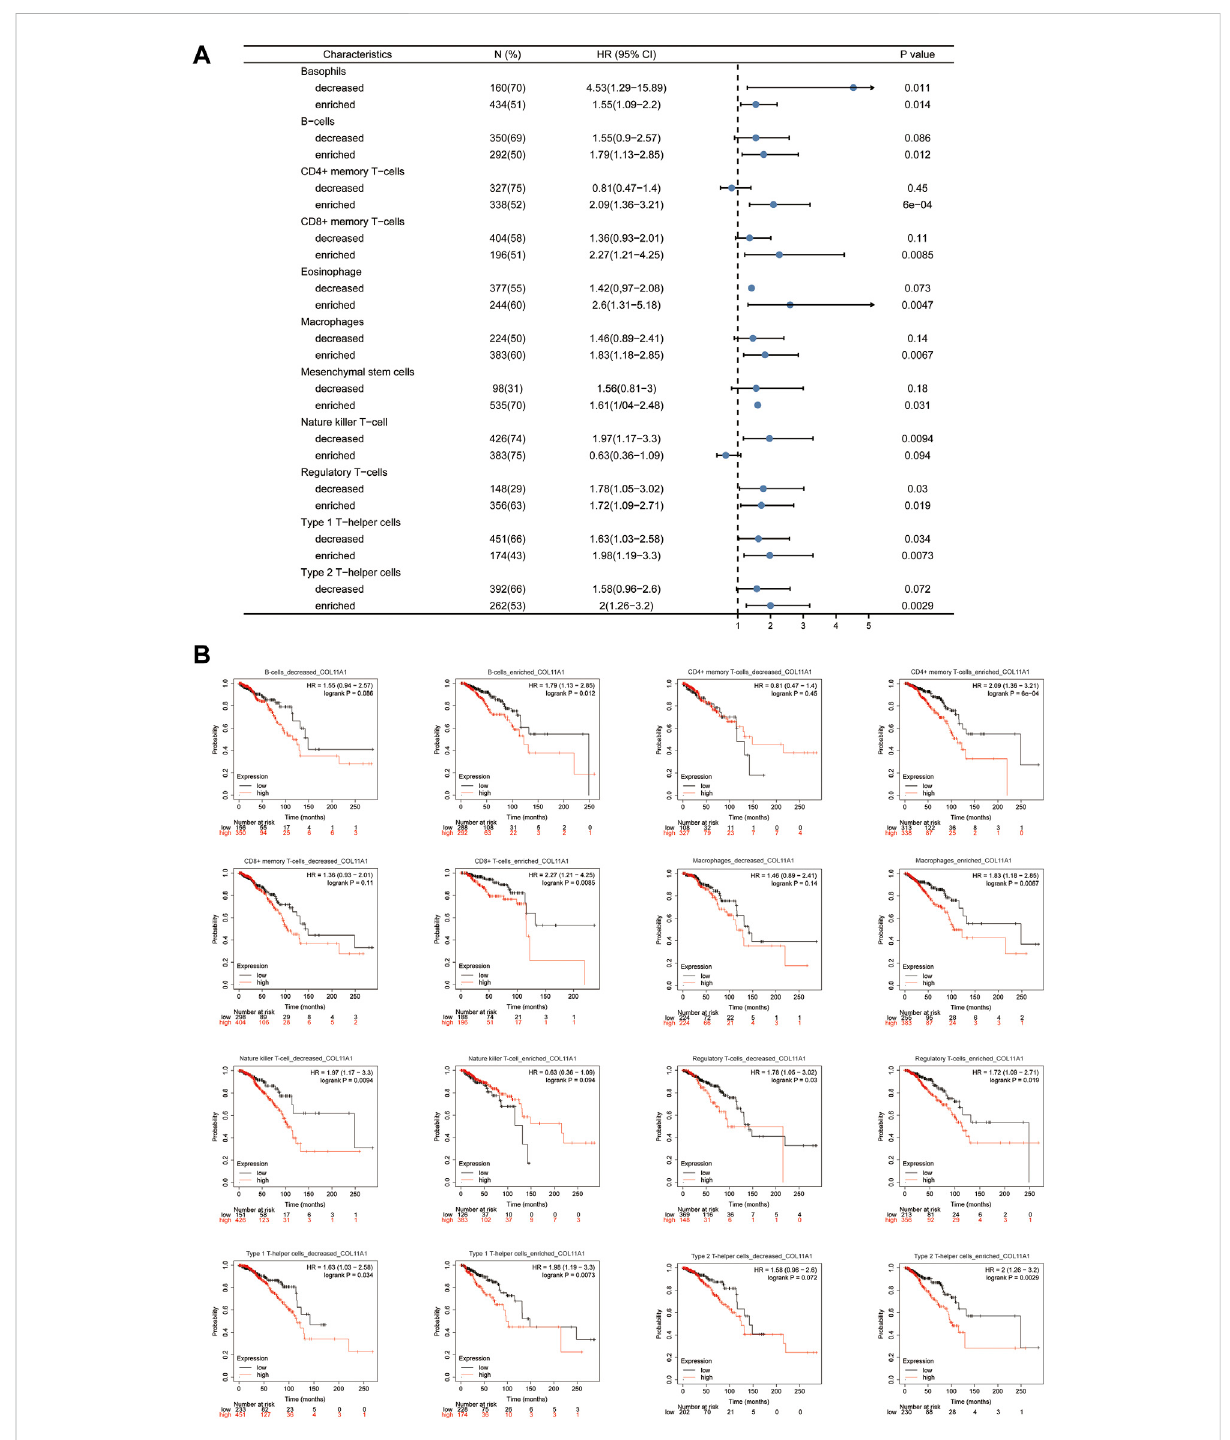
FIGURE 7 Kaplan-Meier survival curves according to high and low expression of COL11A1 in immune cell subgroups in breast cancer. (A) A forest plot shows the prognostic value of COL11A1 expression according to different immune cell subgroups in BRCA patients. (B) Correlations between COL11A1 expression and OS in different immune cell subgroups in BRCA patients were estimated by Kaplan-Meier